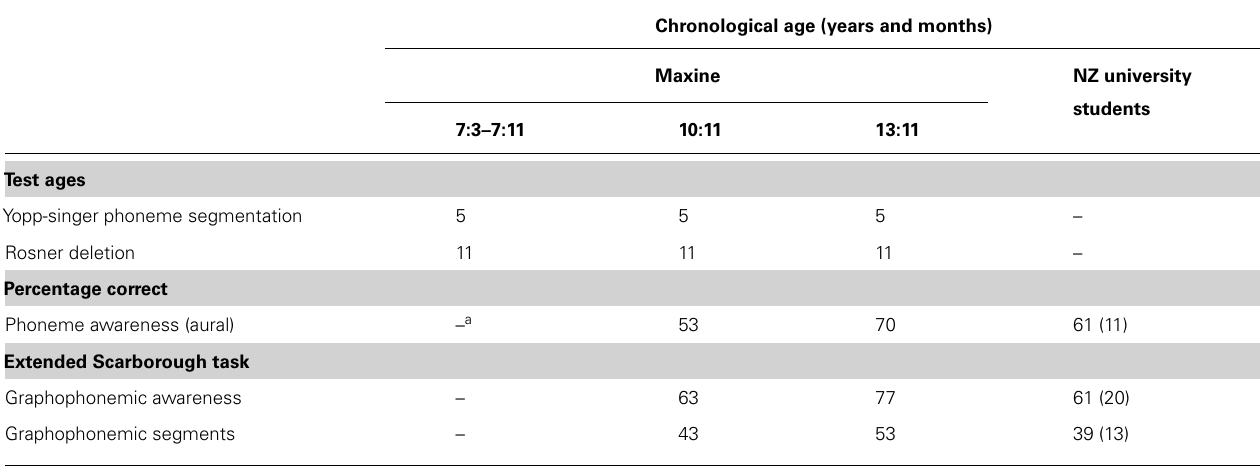
Table 1 |Test age levels for phonological awareness for Maxine at chronological ages 7:3 to 13:11, and mean percentage correct on phoneme awareness and the extended Scarborough task for Maxine and New Zealand university students without phonics instruction (standard deviation in